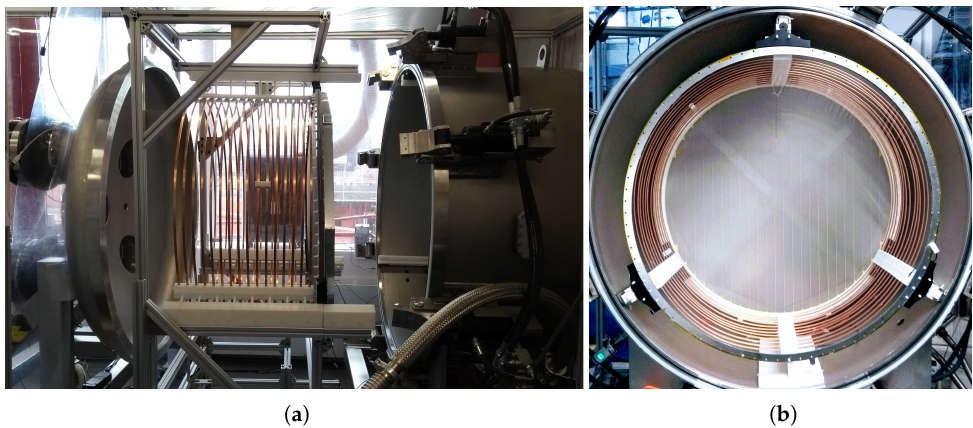
Figure 6. ( a ) The field cage before insertion into the pressure vessel and ( b ) after insertion. The latter picture is photographed through the high-transparency cathode towards the amplification region and shows the full